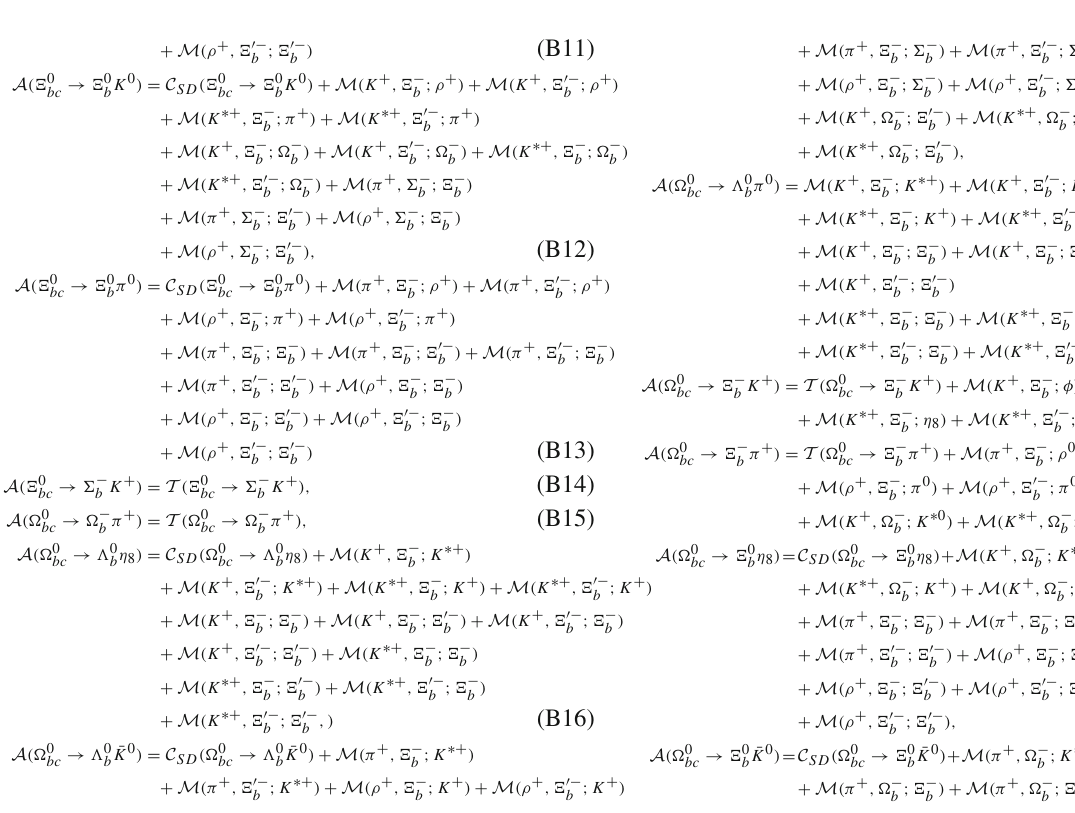
Table 8 Strong coupling constants of V B ¯